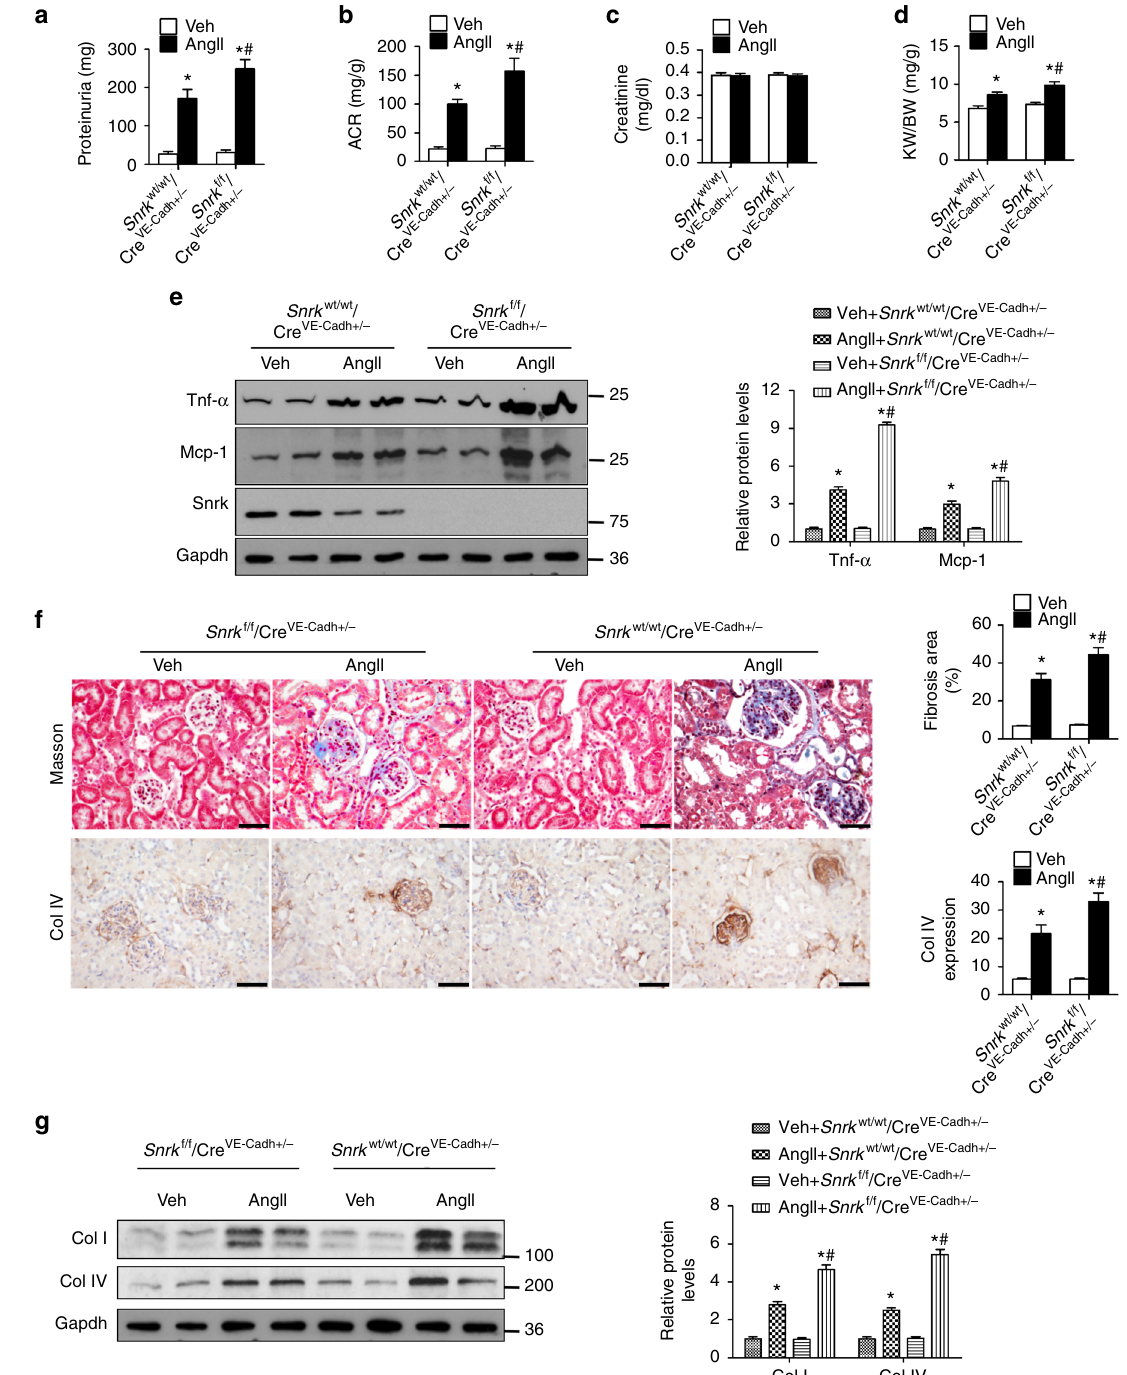
Fig. 7 Deletion of endothelial Snrk exacerbates AngII-induced renal injury. Eight-week-old male wild-type (WT, Snrk wt/wt /Cre VE-Cadh + / − ) and Snrk endothelial-speci fi c knockout ( Snrk f/f /Cre VE-Cadh + / − ) mice were infused with a vehicle control or AngII for 4 weeks. a Albumin excretion rates. b Albumin/creatinine ratio. c Serum creatinine levels. d Kidney weight to body weight ratio. e Western blot analysis of Mcp-1 and Tnf- α levels in mouse kidneys. f Representative images of trichrome staining and immunohistochemical staining of collagen type IV (Col IV) in kidney tissues (scale bar = 50 µ m). g Western blot analysis of collagen type I and IV levels in mouse kidneys. For all experiments, n = 8 per group; * p < 0.05 relative to vehicle control; # p < 0.05 relative to WT mice/AngII. Statistical analysis was carried out with a Student ’ s two-tailed t -test. The corresponding source data are available in the Source Data fi AngII exposure similarly resulted in higher levels of renal fi brosis speci fi c Snrk deletion likely exacerbates AngII-induced renal in Snrk f/f /Cre VE-Cadh + / − mice relative to the WT mice, as evi- lesions. Upon AngII exposure, Snrk f/f /Cre VE-Cadh + / − mice exhibited signi fi cantly higher cytokine mRNA and protein levels denced by trichrome staining and collagen type I and IV relative to the WT mice (Fig. 7e and Supplementary Fig. 12a). expression (Fig. 7f, g, and Supplementary Fig. 12b).